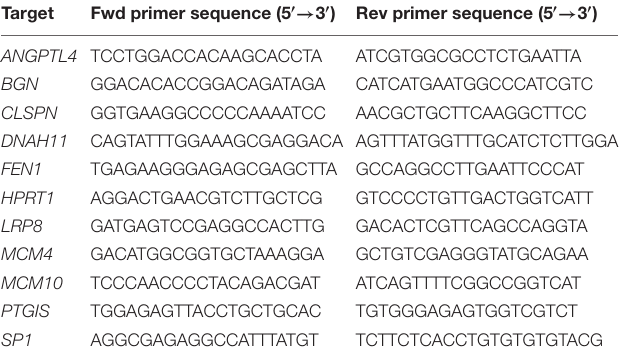
TABLE 2 | qPCR primer sequences. Target